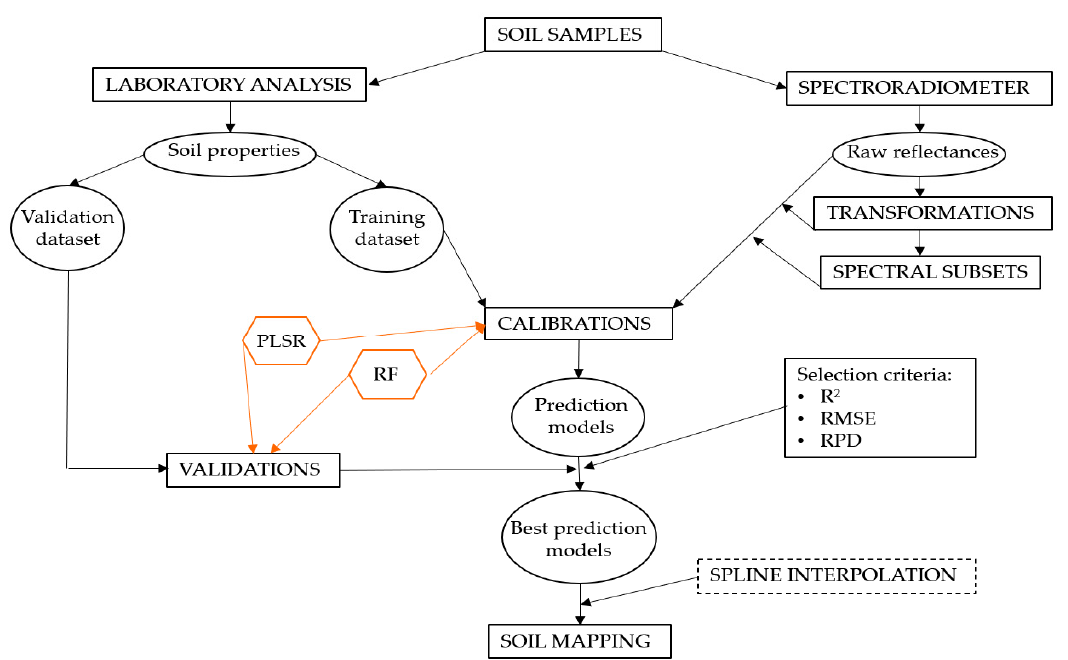
Figure 2. Flowchart of the methodology used: random forest (RF) and partial least square regression (PLSR).